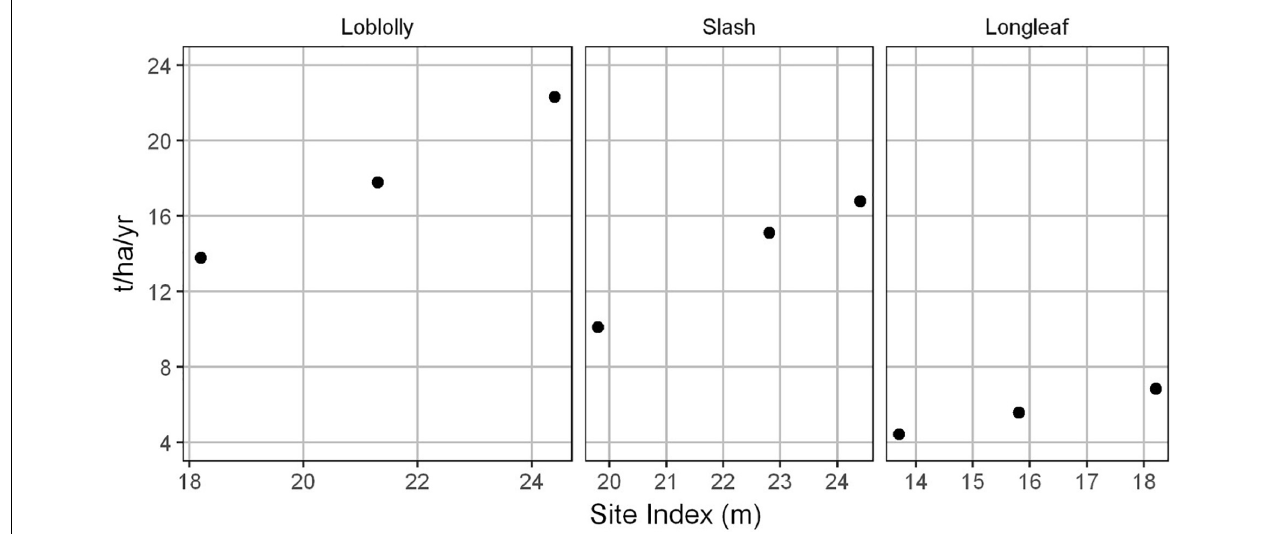
FIGURE 3 | Mean Annual Increment (MAI) for loblolly, slash, and longleaf pines relative to the respective site indices. Site Index is based on the average height (m) at the base stand age of 25 years for all the species.